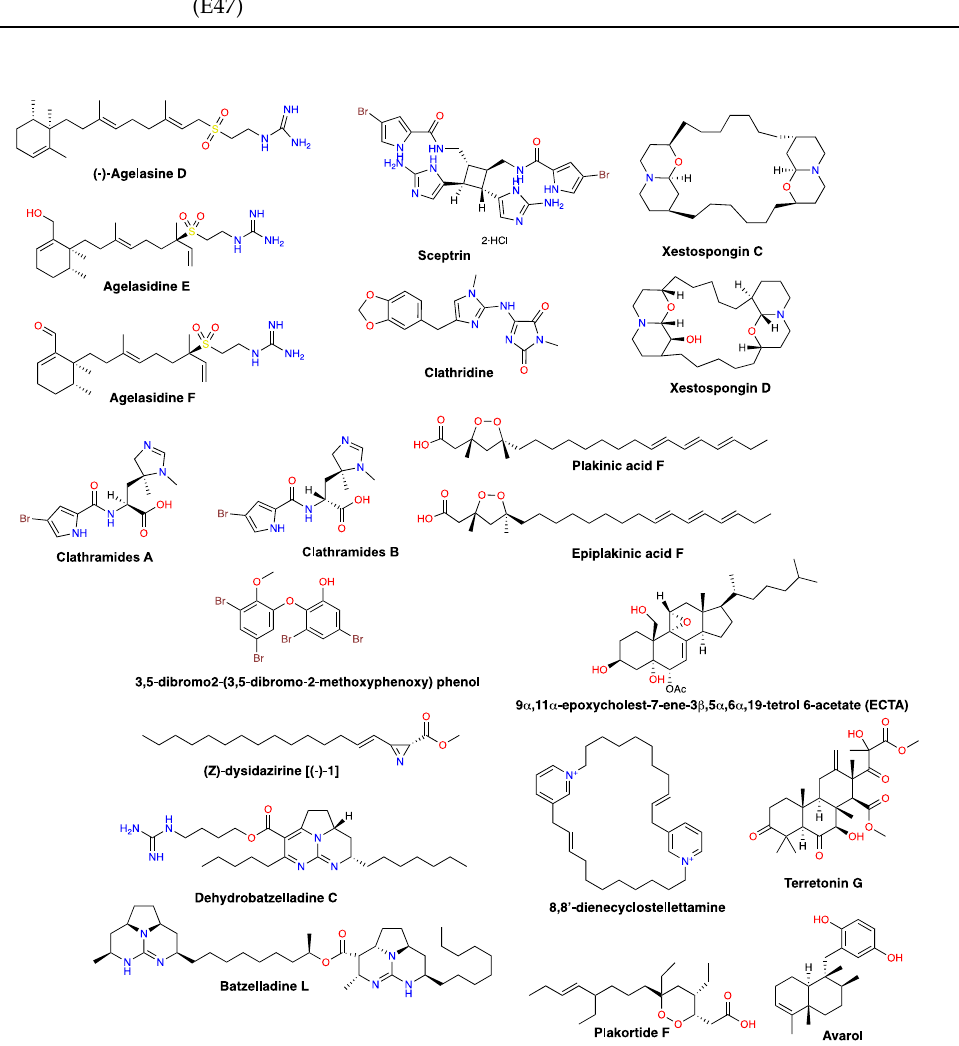
Figure 10. Selected structures of compounds with reported antifungal activity isolated from marine organisms.